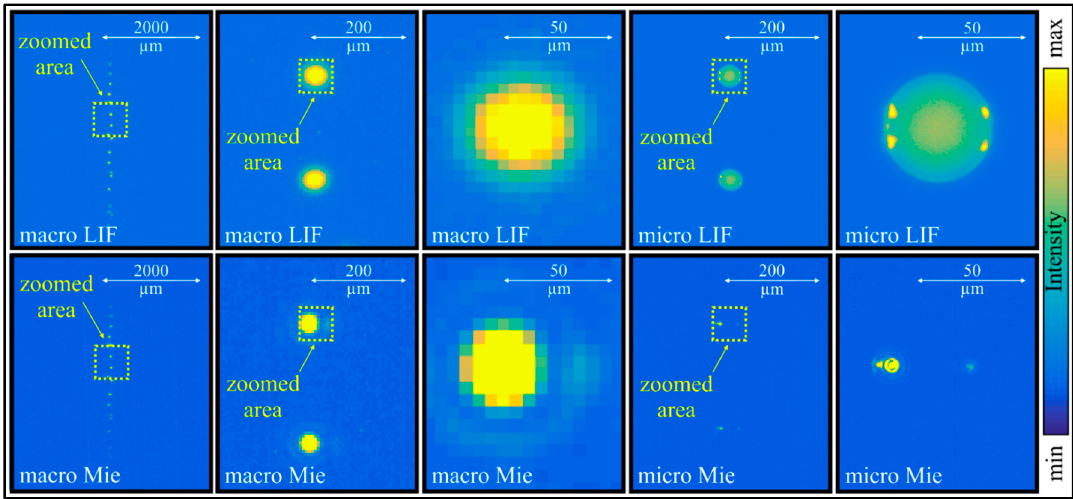
Figure 3. Simultaneous microscopic and macroscopic LIF and Mie images of single micrometric Toliso droplets (50 µm) at the reference conditions (293 K, nile red 100 mg/l).